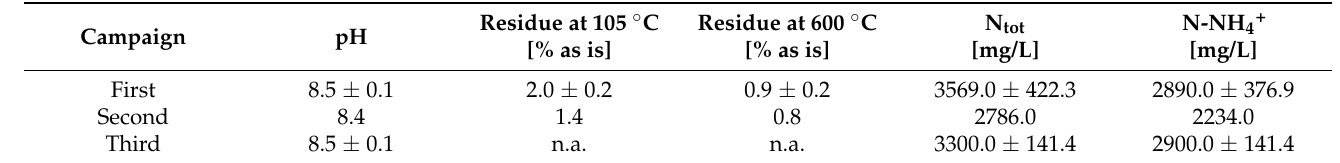
Table 3. Characteristics of the digestate entering the reactor for each campaign (sample time 0). n.a.: not available. N tot = total nitrogen.